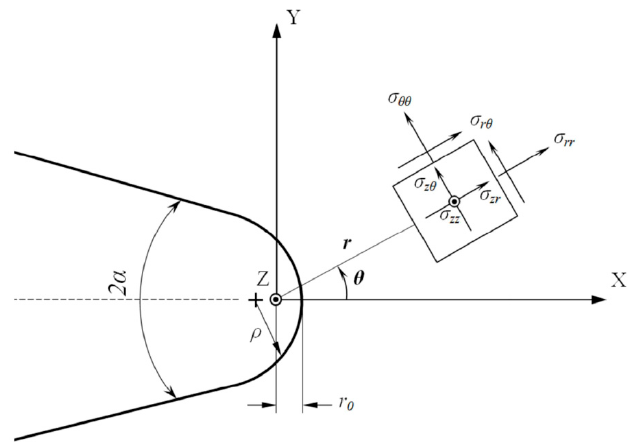
Figure 4. Schematic of the VIMC.